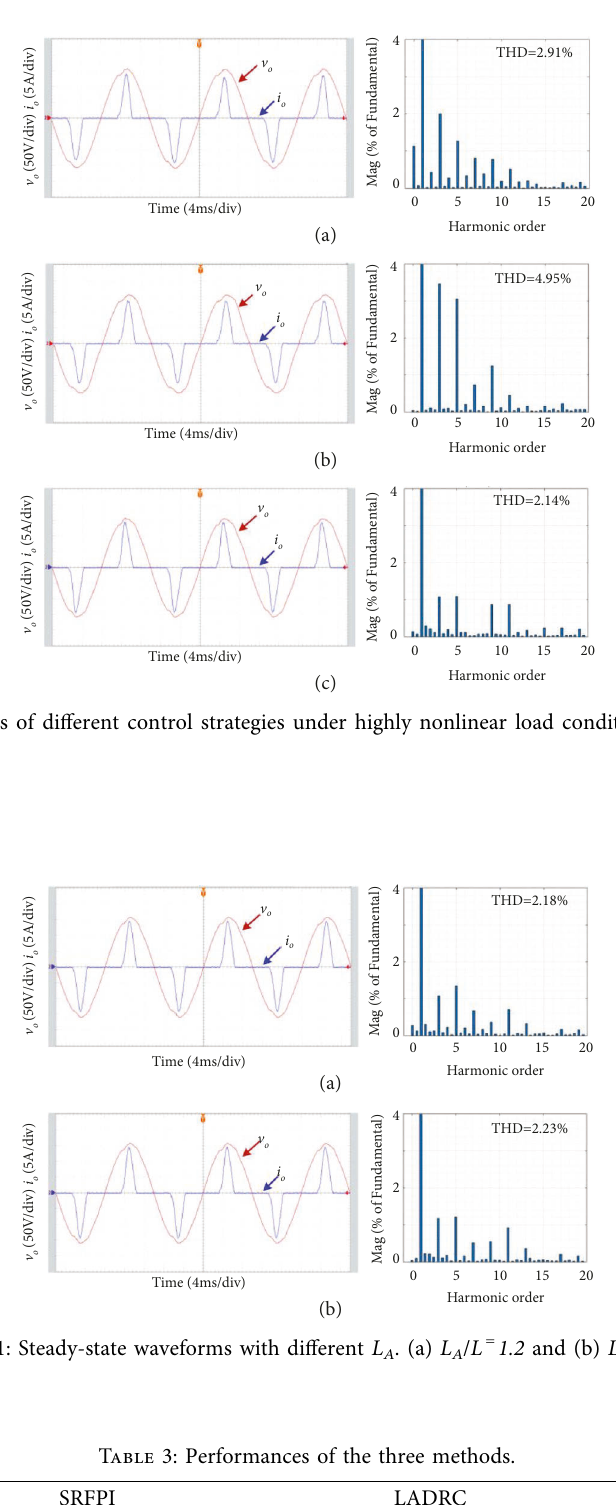
� 1.2 and (b) L � A . (a) L A / L A /L